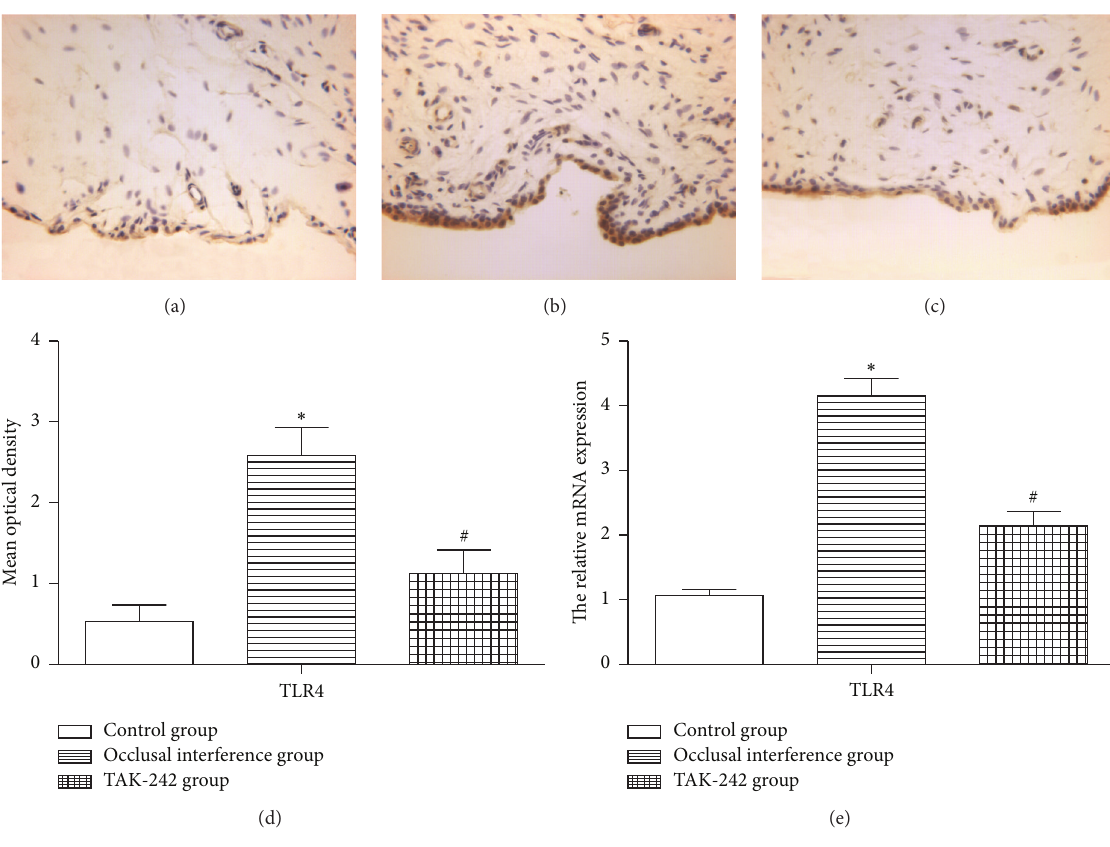
Figure 2: The expression of TLR4 in the synovial membranes. (a) Immunohistochemical staining for TLR4 in the membranes of the control group. (b) Immunohistochemical staining for TLR4 in the membranes of occlusal interference group. (c) Immunohistochemical staining for TLR4 in the membranes of TAK-242 group. (d) The mean optical density of each group. (e) The relative mRNA expression of TLR4 of each group. As the results shown, in comparison with the control group, the expression of TLR4 was significantly increased in the occlusal interference group at both protein and mRNA levels. However, this effect could be inhibited significantly after treatment with the TAK-242. Datashowsallthevaluesfromindependentsamplesof 𝑛 = 6 , ∗ 𝑃 < 0.05 versuscontrolgroupand # 𝑃 < 0.05